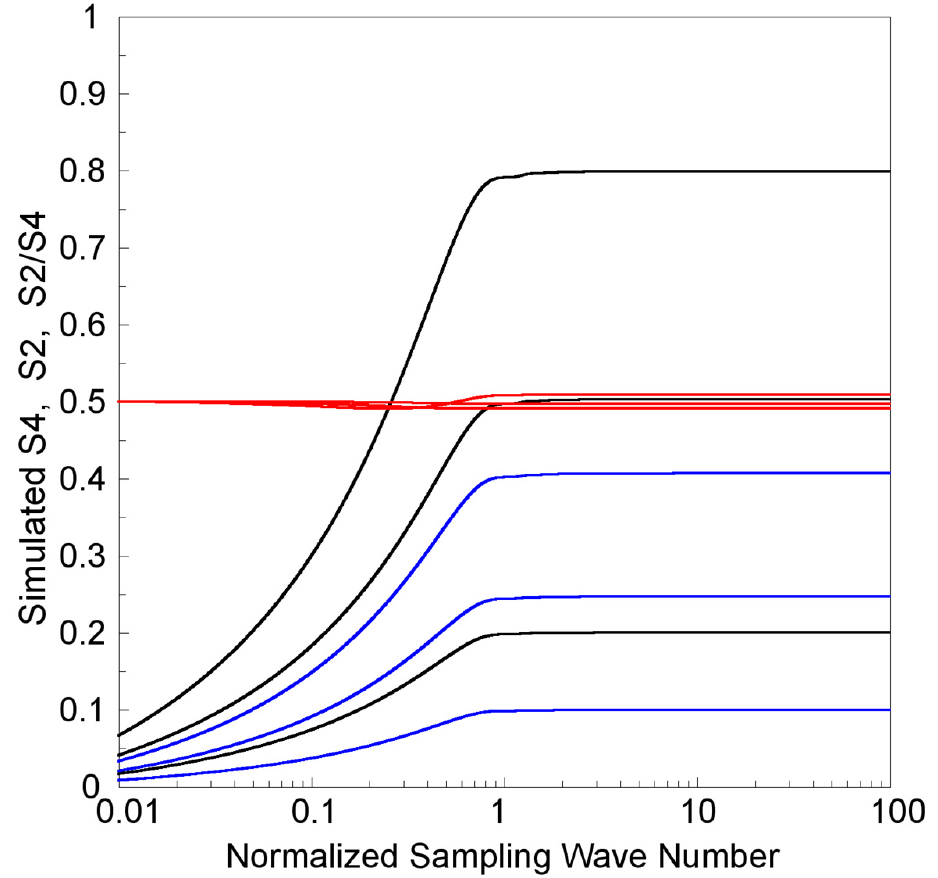
Figure 3. For different complete (saturated) S 4 values of 0.8, 0.5, and 0.2, simulated scintillation index S 4 (shown as the black lines) and normalized signal amplitude standard deviation S 2 (shown as the blue lines) as functions of a normalized sampling wave number κ s / κ F in the log scale are shown from top to bottom separately. The ratio of S 2 /S 4 as functions of κ s / κ F are also shown as the red lines, but almost overlap around a value of 0.5.